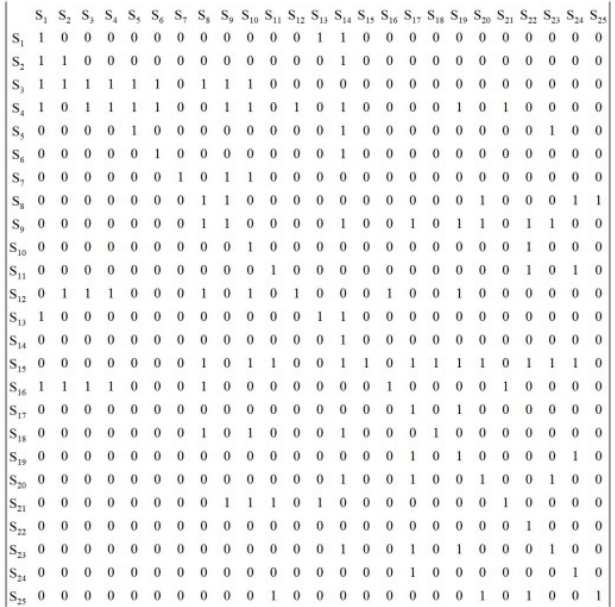
Figure 3. Reachability Matrix M.